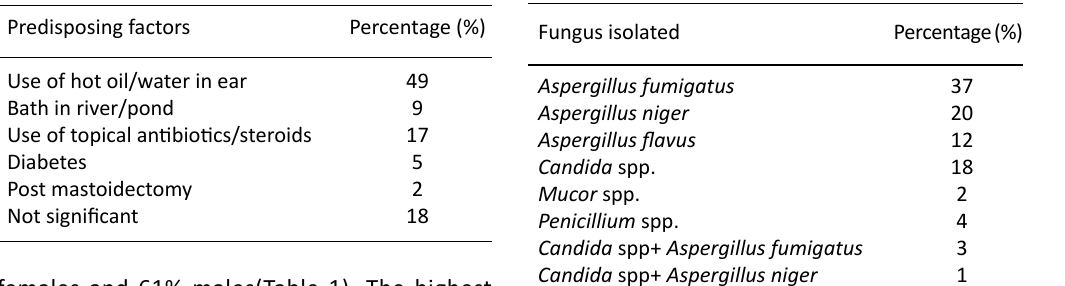
Table 4. Distribution of study population according to predisposing factors